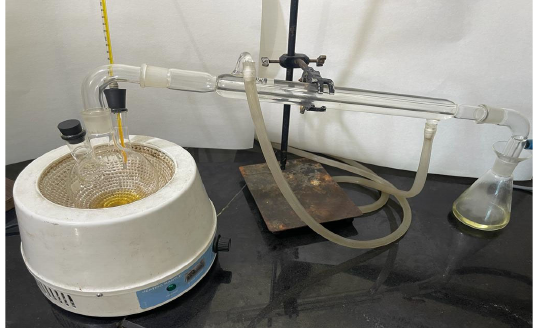
Figure 4. Vacuum distillation process.